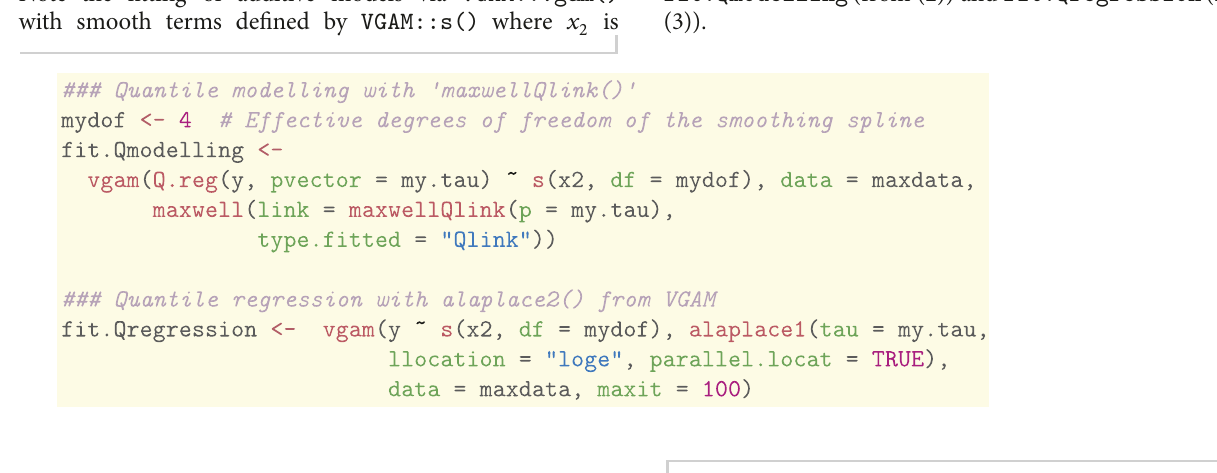
The following code chunk performs steps (2) and